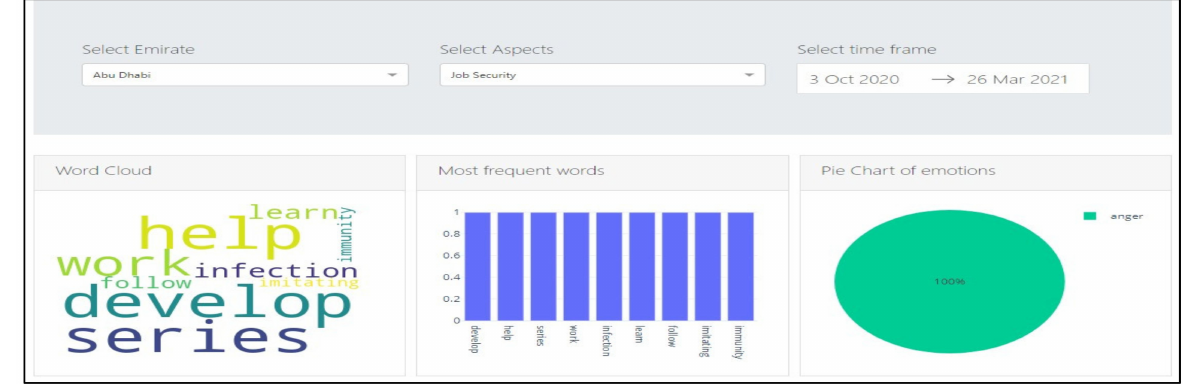
Figure 14. Testing